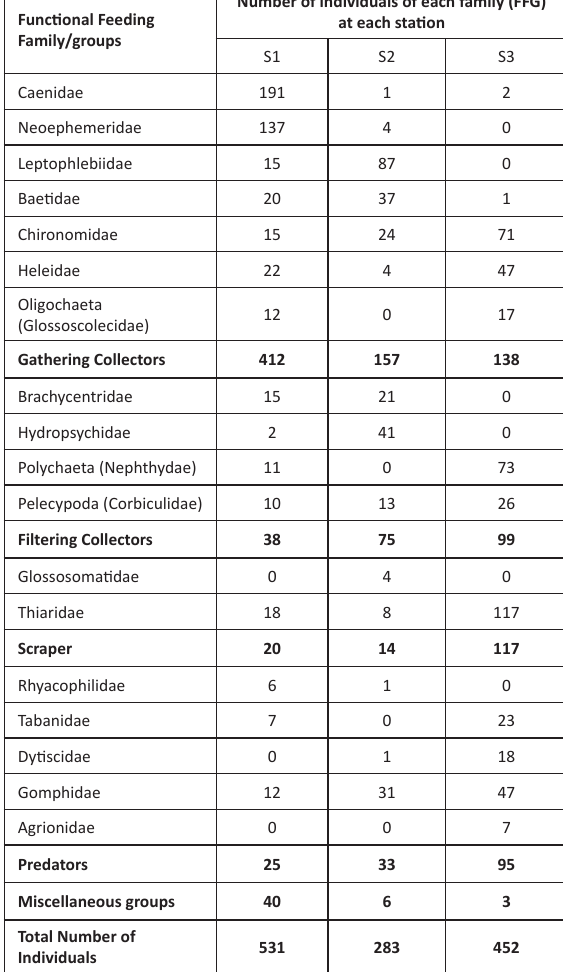
Table. 3 Benthic macroinvertebrate fauna with respect to their Functional Feeding Groups (FFG) for different land uses in the Ken River. Families have been grouped on the basis of their functional role in the ecosystem into FFG, viz., scraper, gathering collectors, filtering collectors, predators. Each family is expressed as number of individuals in the total count from 20 quadrants at each location.